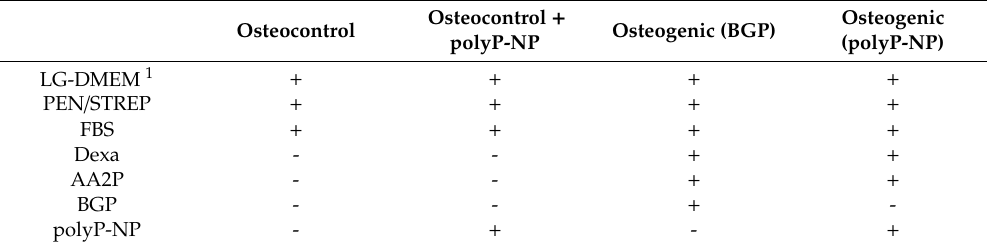
Table 1. Media composition of the four experimental